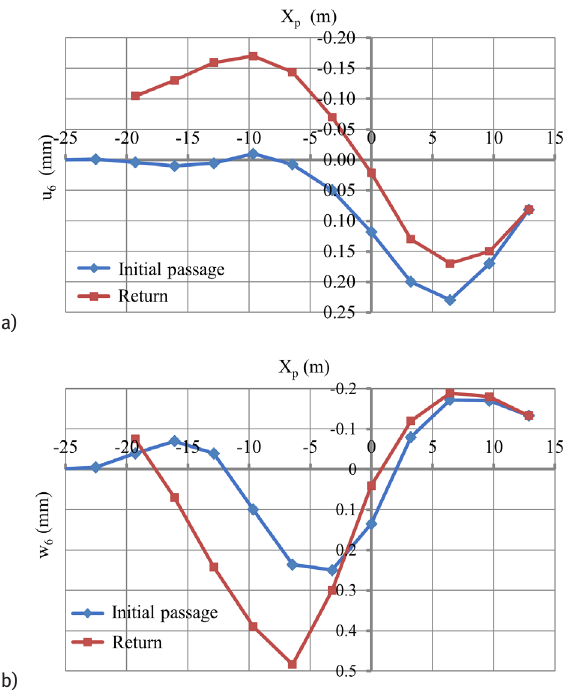
Figure 5: Horizontal (a) and vertical (b) displacement of point 6 during the loading test.